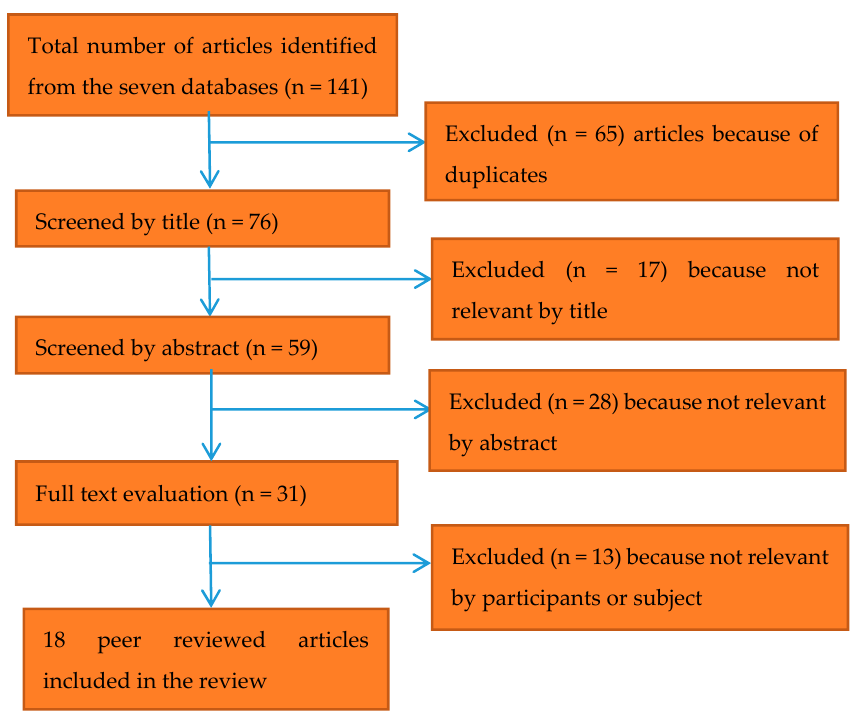
Figure 1. Article selection process.